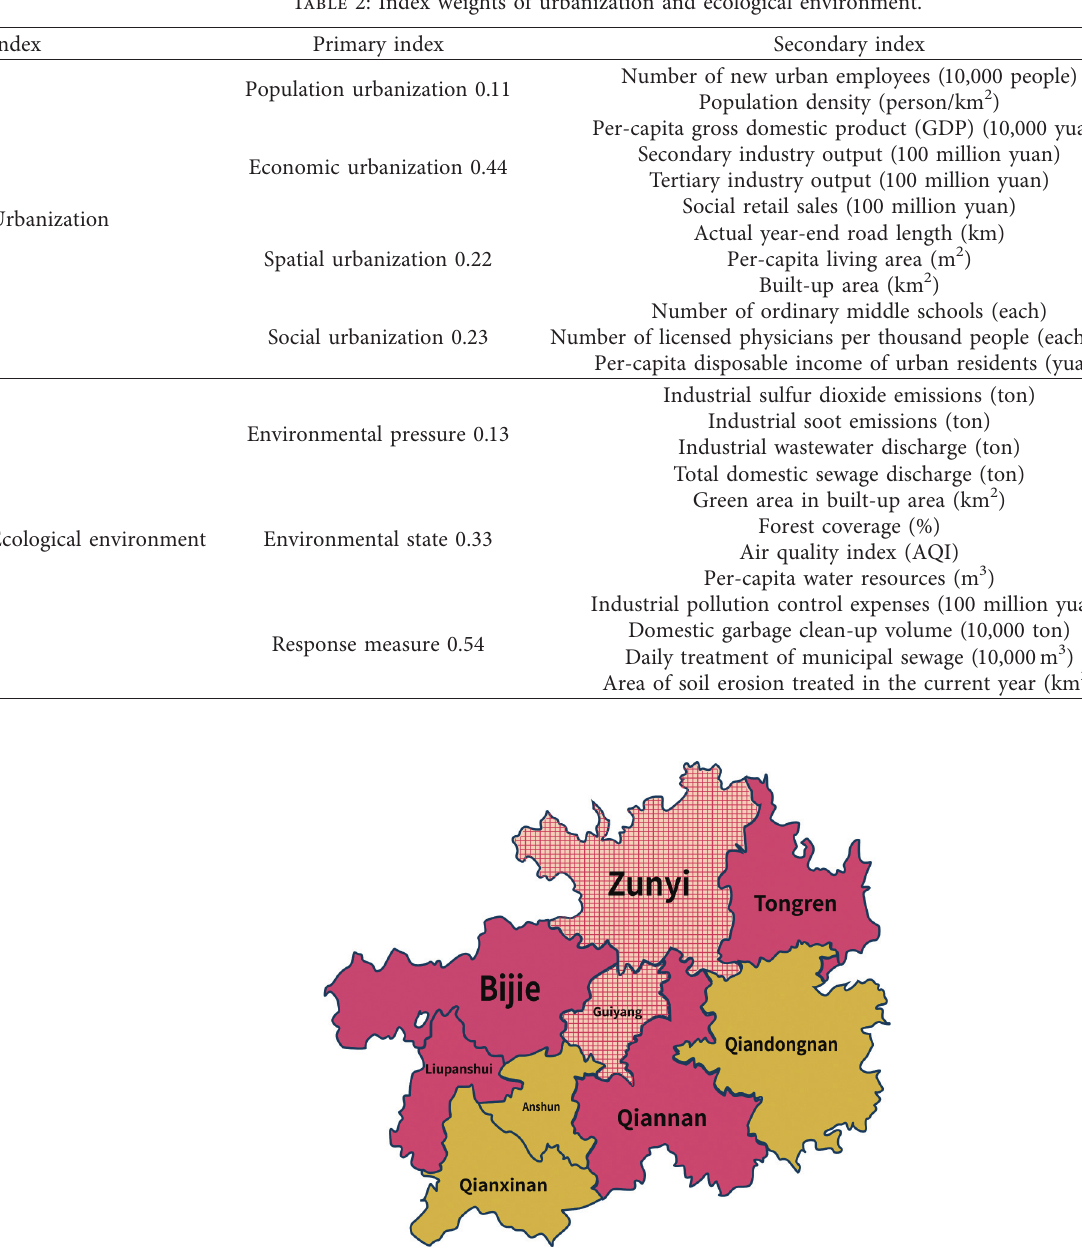
Figure 1: Urbanization scores of different prefectures in Guizhou,